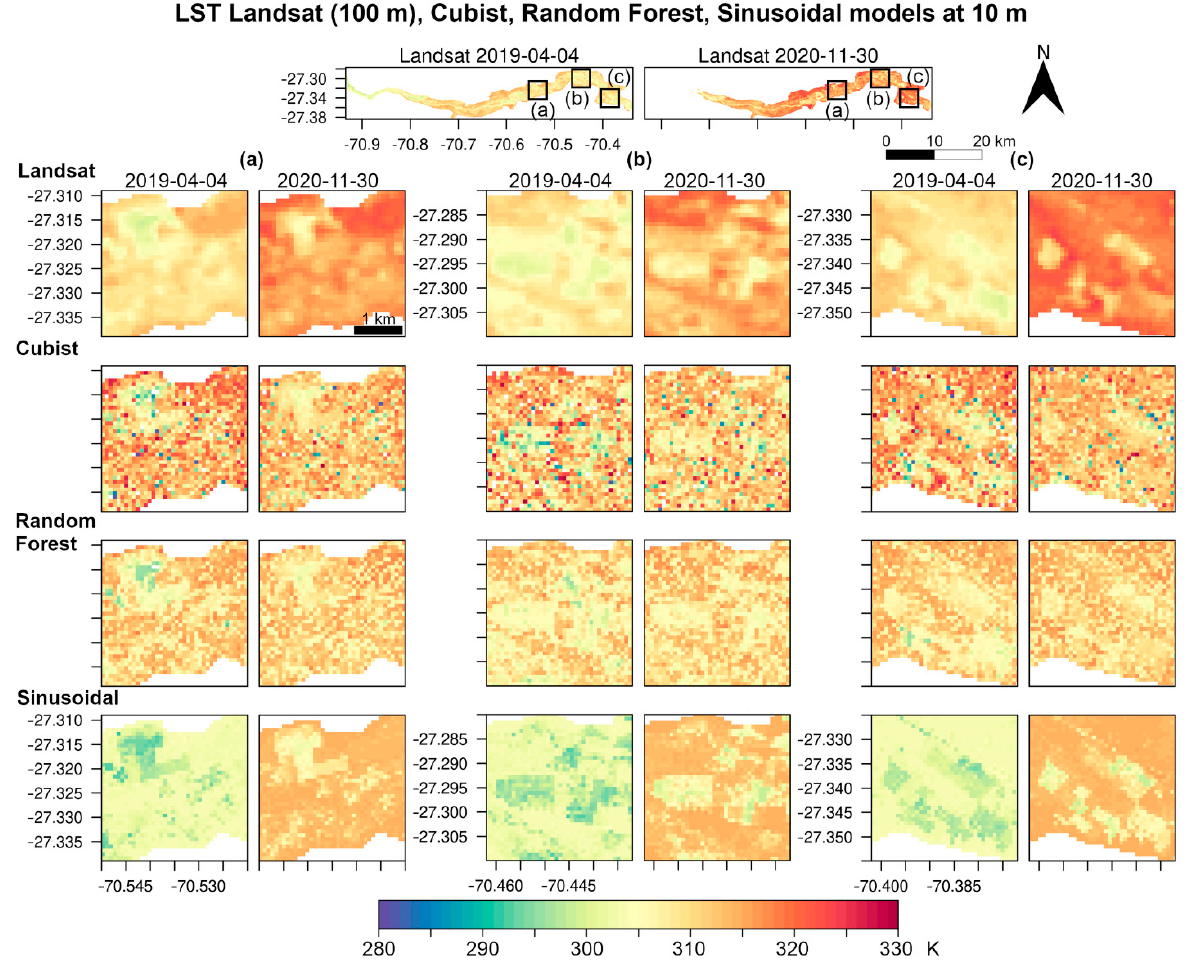
Figure 6. Land surface temperature by Landsat-8 at 100 m and the spatial predictions of LST from Sentinel-2 data using cubist, random forest, and sinusoidal models. The predictions are shown at two dates apr 04 2019 (winter) and nov 11 2020 (late spring) in three locations next to the olives ( a ), vineyards ( b ), and pomegranates ( c )